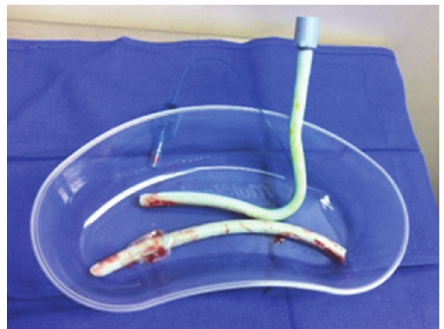
Figure 1: Severed nasoendotracheal tube.